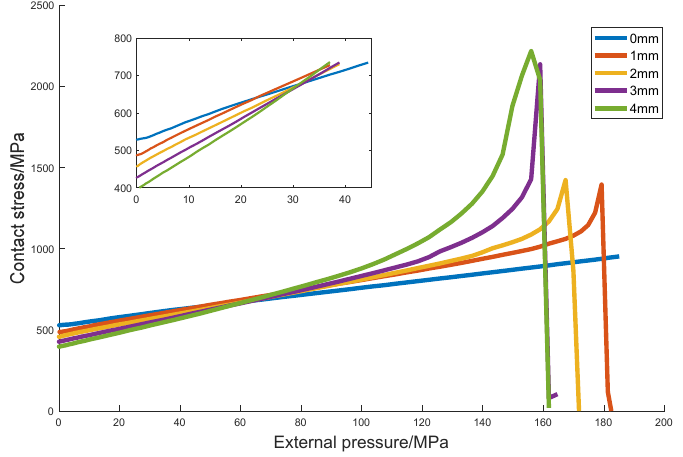
Figure 9. Axial distribution characteristics of stress on sealing surface.